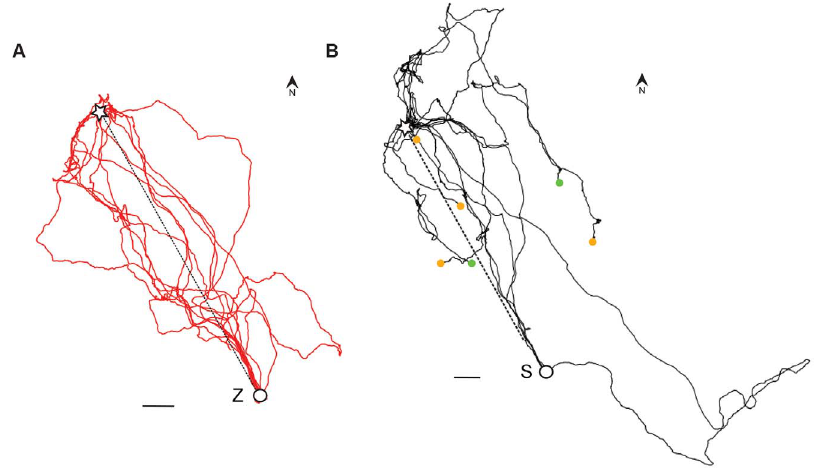
Figure 5. Flight tracks from the same experimental release site. The dotted line is the beeline from the release site, indicated with a star, to the home lofts. (A) The flight tracks of 12 Z-pigeons flying to their home loft Z (Zavallia). The distance from the release site, to the Z-loft is 46 km. (B) The flight tracks of 11 S-pigeons flying to their S-loft (Savran). The distance from the release site to the S-loft is 54 km. An orange dot indicates that the pigeon stopped flying and was pausing until the GPS ran out of battery power. A green dot indicates that the pigeon was still flying while the GPS ran out of battery power. The bars in both pictures represents 5 km.